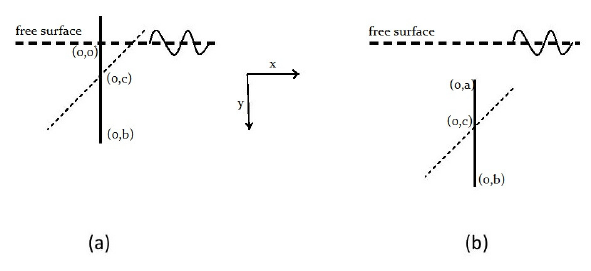
Figure 1. Diagram of rolling of (a) partially immersed plate and (b) submerged